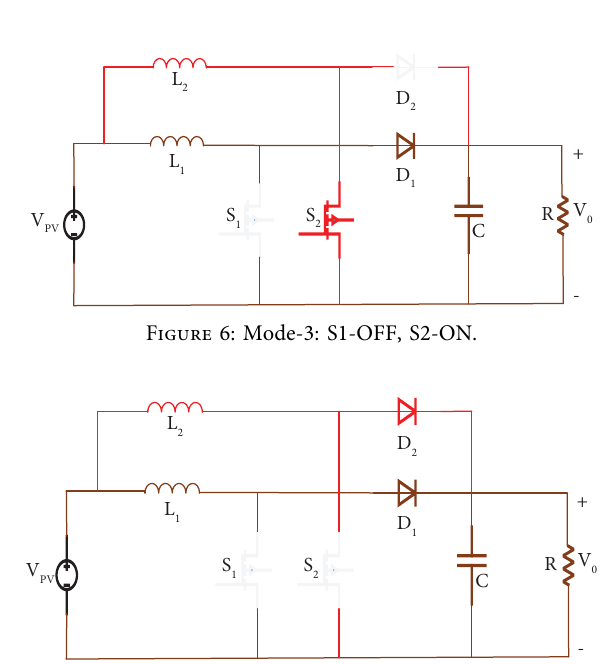
Figure 5: Mode-2: S1-ON, S2-OFF.